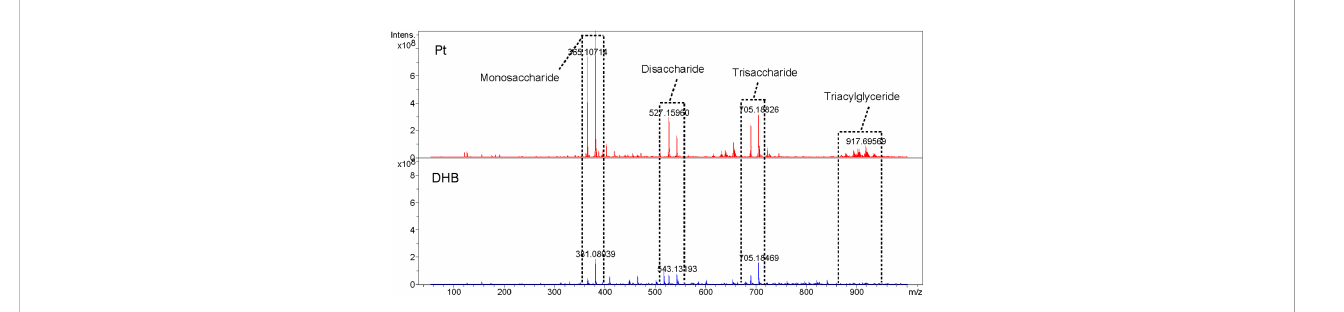
FIGURE 2 Metabolite detection of soybean extracts by MALDI-FTICR MS using pre-coated Pt and DHB as the matrix, respectively(At 50% laser